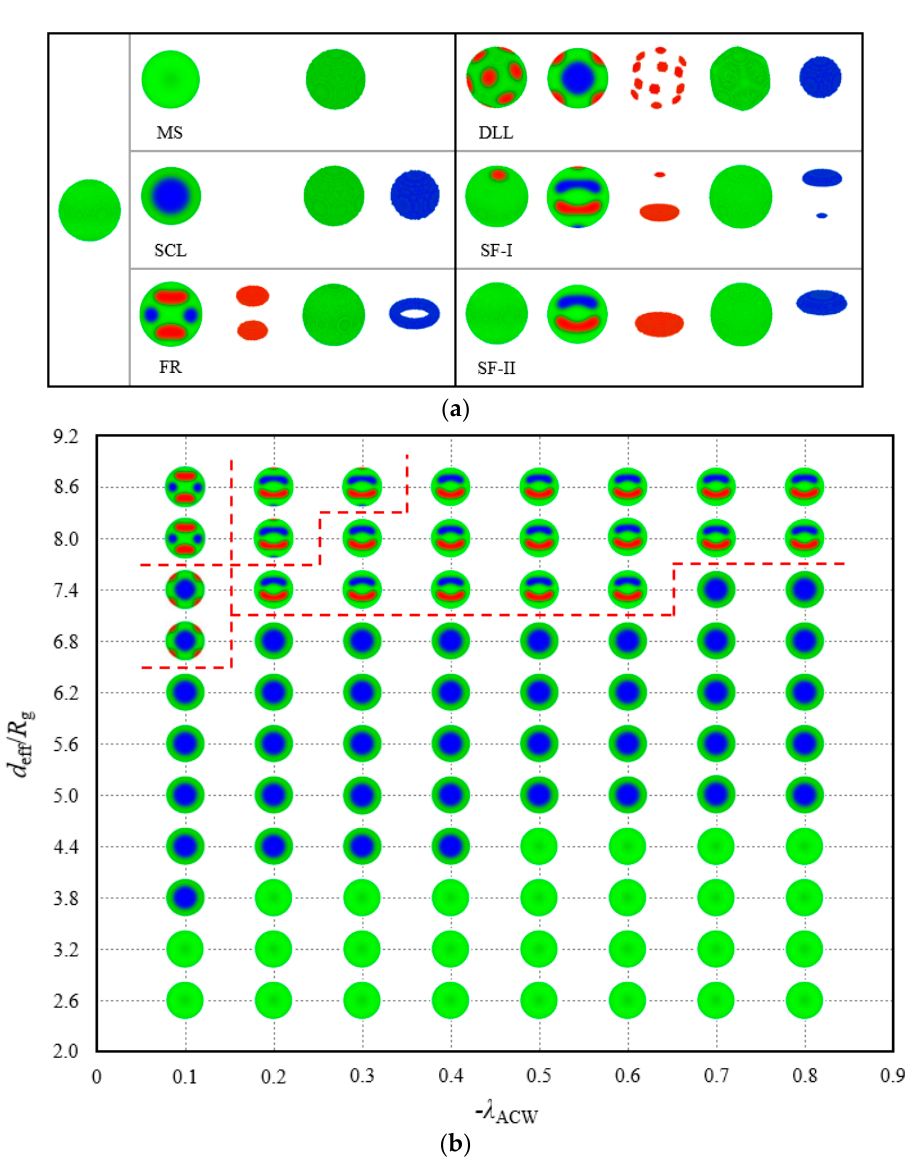
Figure 5. ( a ) Structures of ABC linear triblock copolymers in a spherical cavity of effective diameters, d eff = 2.60–8.60 R g . AC monomers are attracted to the surface, whereas B monomers are repelled from the surface. Red, green and blue represent the A-, B- and C-rich domains, respectively. ( b ) Phase diagram of structures in plot ( a ). The phase diagram is constructed by effective diameters, d eff and AC-attractive intensity, − λ ACW . The red dashed lines are edge guides for the phase boundaries.